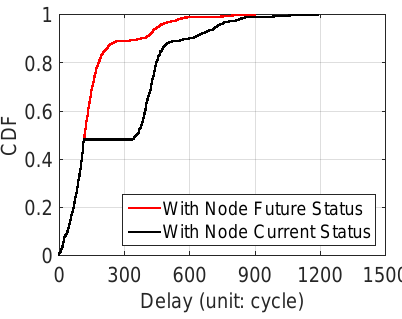
Figure 10. The delay distribution of Pido with future node status and current node status (network size: 225; average under-water time: 360